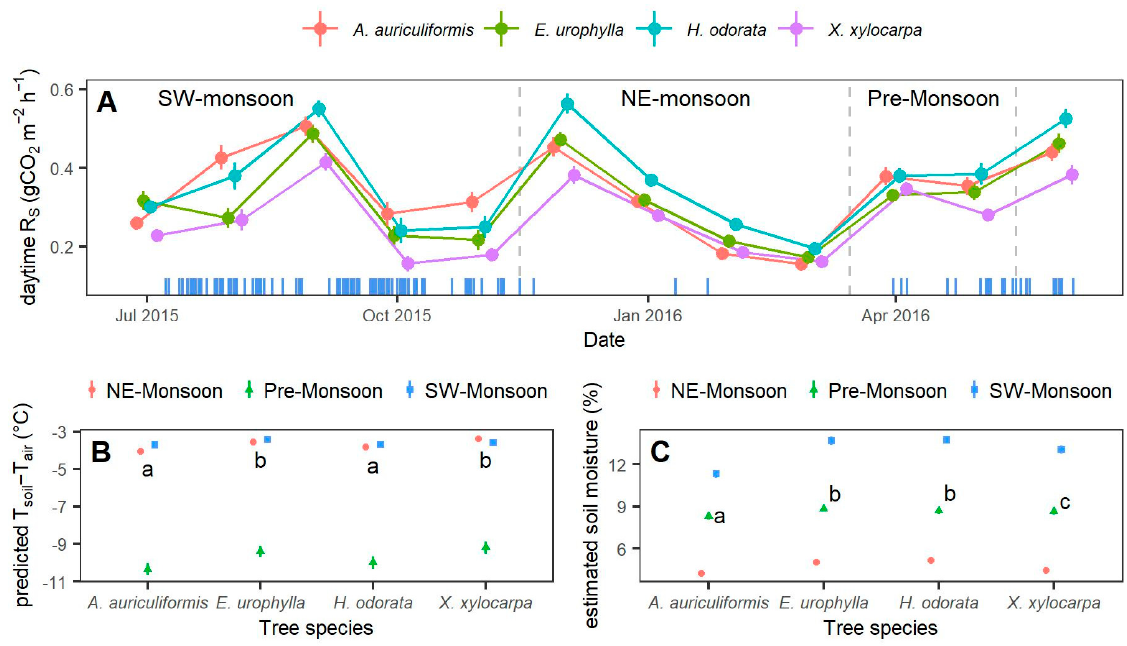
Figure 3. Comparison of soil conditions across the four tree species: ( A ) carbon stock, ( B ) soil organic matter (SOM), ( C ) C/N-ratio, ( D ) bulk density, ( E ) pH, and ( F ) total nitrogen. The dot represents the median value, the vertical lines represent the interquartile range (IQR), and the widths of the violin plots indicate the density of observations at each level. Letters represent significant differences between medians, as determined by Dunn’s test ( p < 0.05).